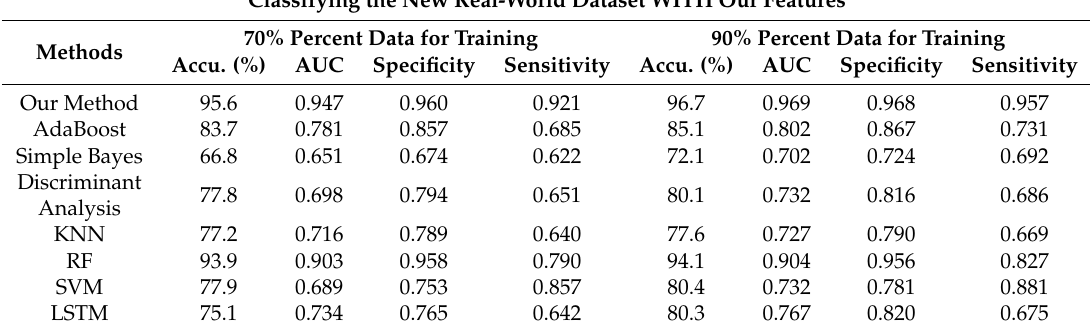
Table 8. The comparison among eight methods on our real-world dataset with the proposed feature extraction method. After comparing with the values of classification accuracy and AUC in Table 7, it shows that the performance of any method is improved using our feature extraction method. Classifying the New Real-World Dataset WITH Our